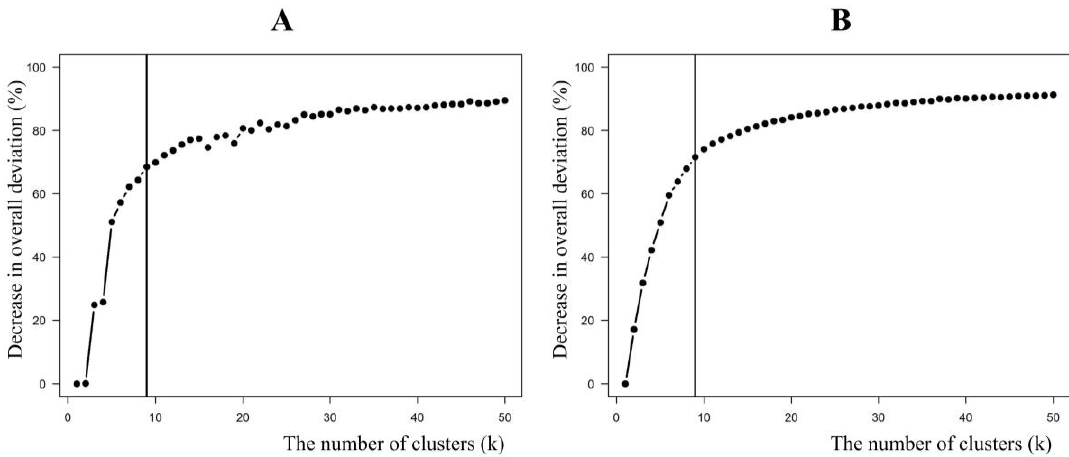
Figure 3. Decrease in overall deviation (DiD) based on predicted PM 2.5 concentration ( A ) and five geographic variables ( B ) against the numbers of clusters (k) (vertical lines indicate nine clusters). Distributions of the numbers of current and subject locations varied across clusters (Table 2).